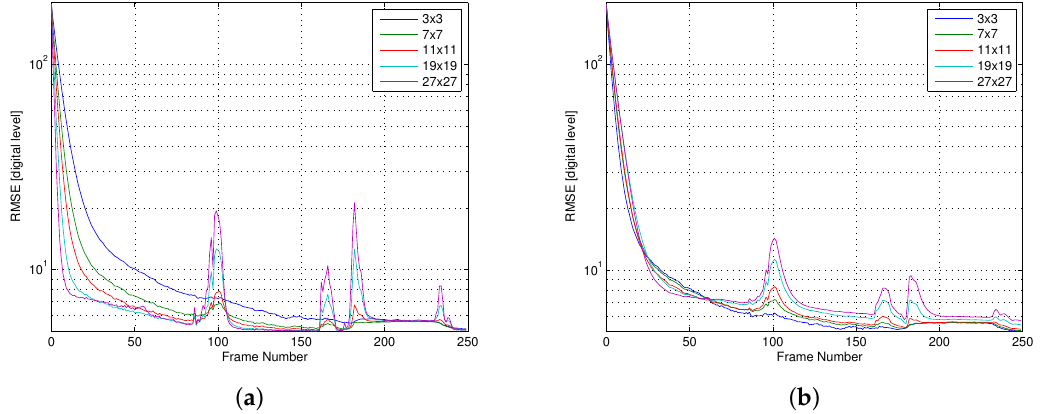
Figure 2. The root mean square error (RMSE) between a reference image and a non-uniformity (NU) compensated image using the proposed method, as a function of the frame number, and for different values of the window size. ( a ) The same learning rate was used for all window sizes; ( b ) The learning rate was adjusted, for each window size, to obtain a similar settling time.